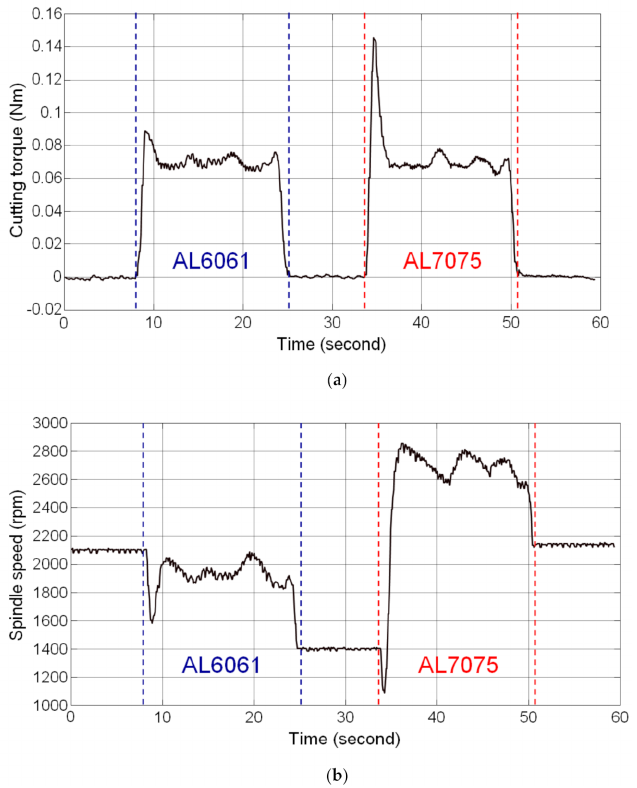
Figure 6. Results of thread milling experiments on the workpiece with stacked materials (SSM control). ( a ) Estimated cutting torque; ( b ) Actual spindle speed.